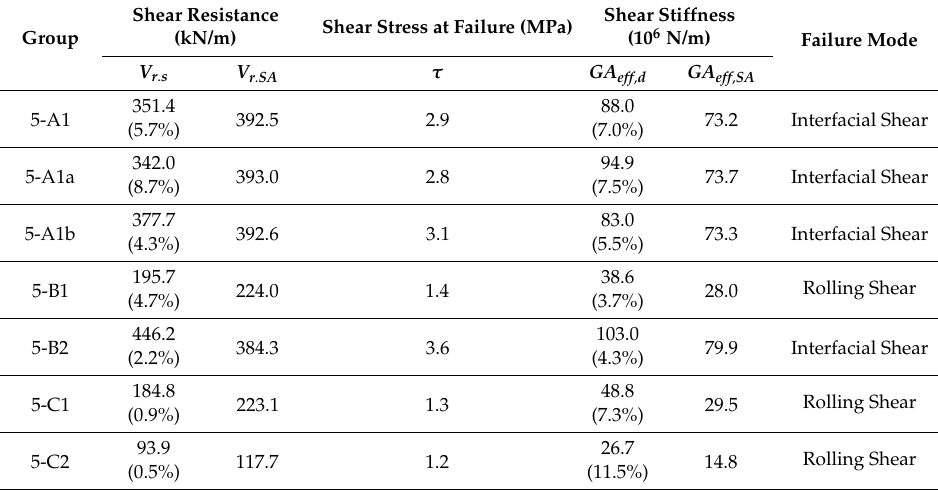
Table 3. Shear properties of 5-layer